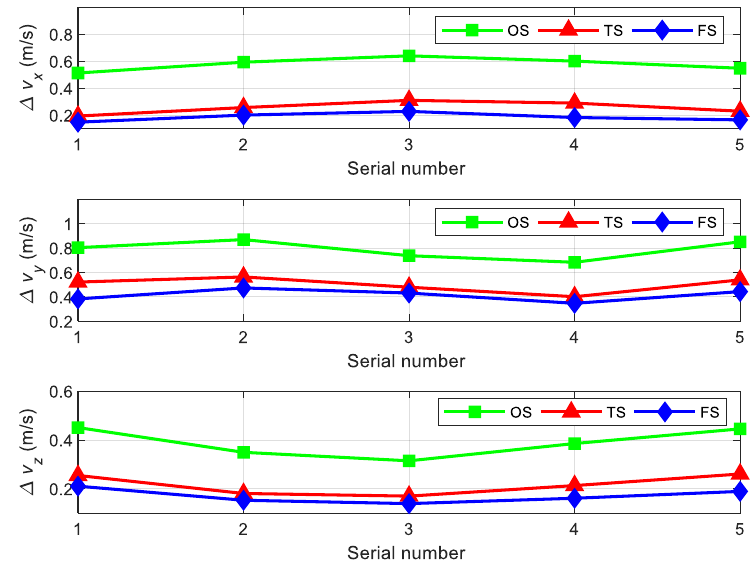
Figure 15. The coning error of SINS in X, Y, and Z directions.